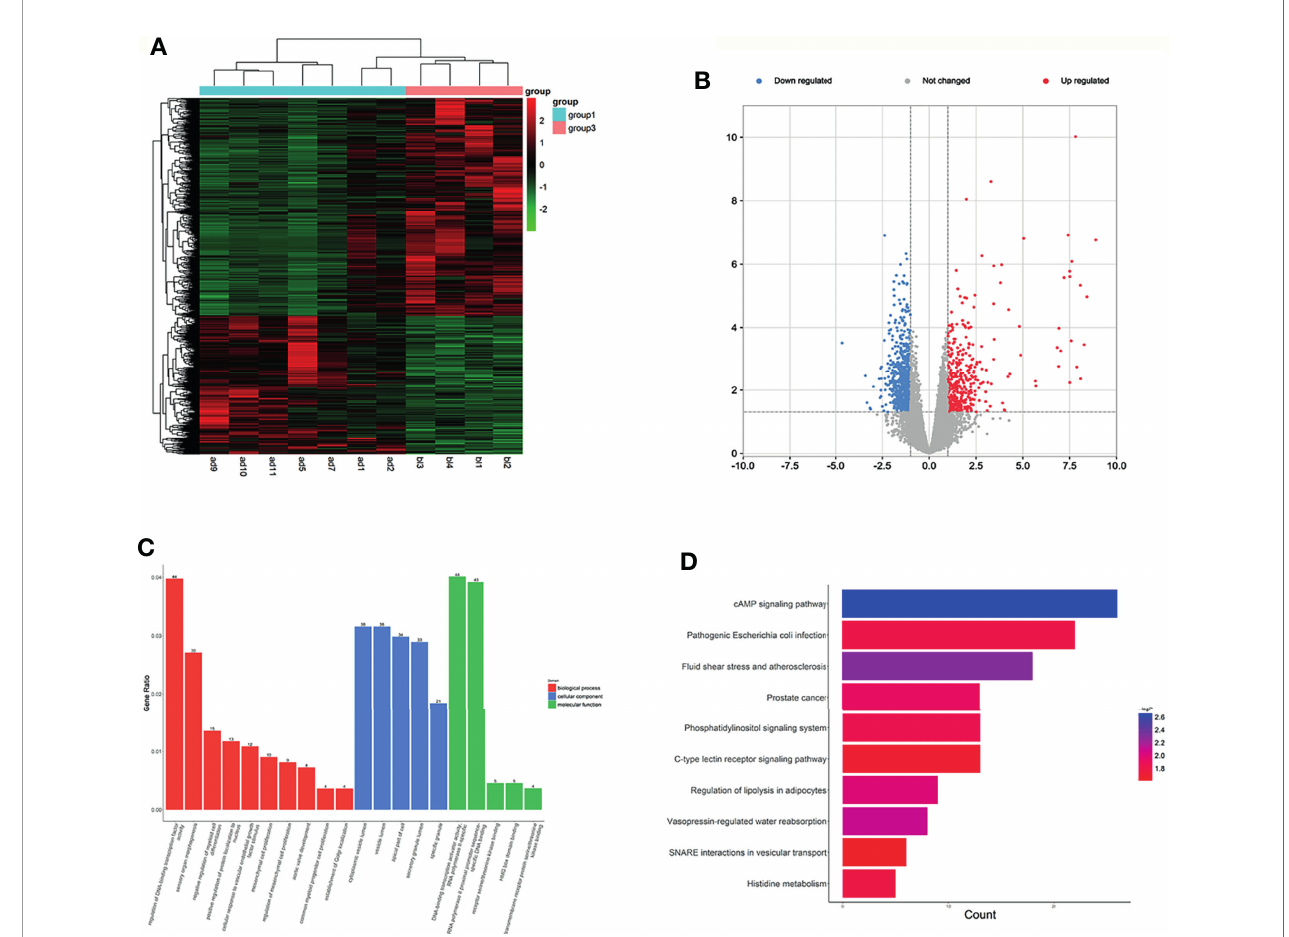
FIGURE 2 | Expression pro fi les of lncRNAs in plasma between LUAD patients and LUH controls. (A) Heatmap of differentially expressed lncRNAs in LUAD patients and controls (group 1, LUAD plasma; group 3, LUH plasma). (B) Volcano plot of differentially expressed lncRNAs. (C) Enrichment analysis of GO terms and pathways of the differentially expressed lncRNAs. (D) KEGG pathway analysis of the differentially expressed mRNAs between two